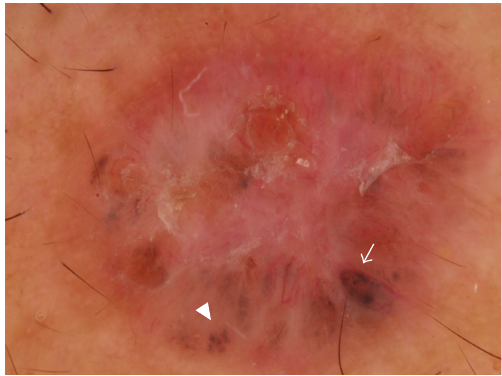
Figure 1: Representative photograph of dermoscopy. Morphologic features of BCC, such as telangiectasia (arrow), blue-gray globules (arrowhead), and ulceration, are